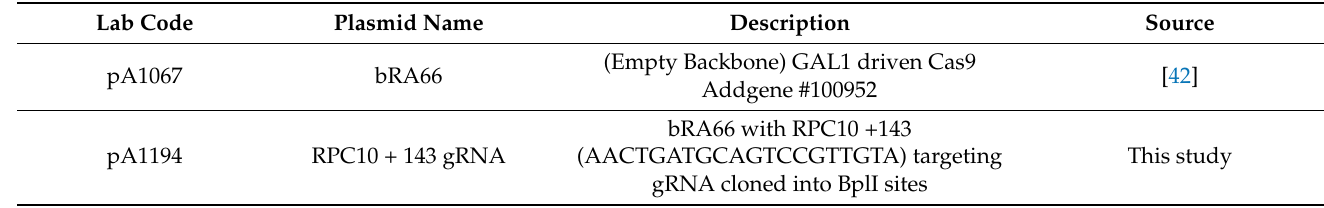
Table 2. Plasmids.